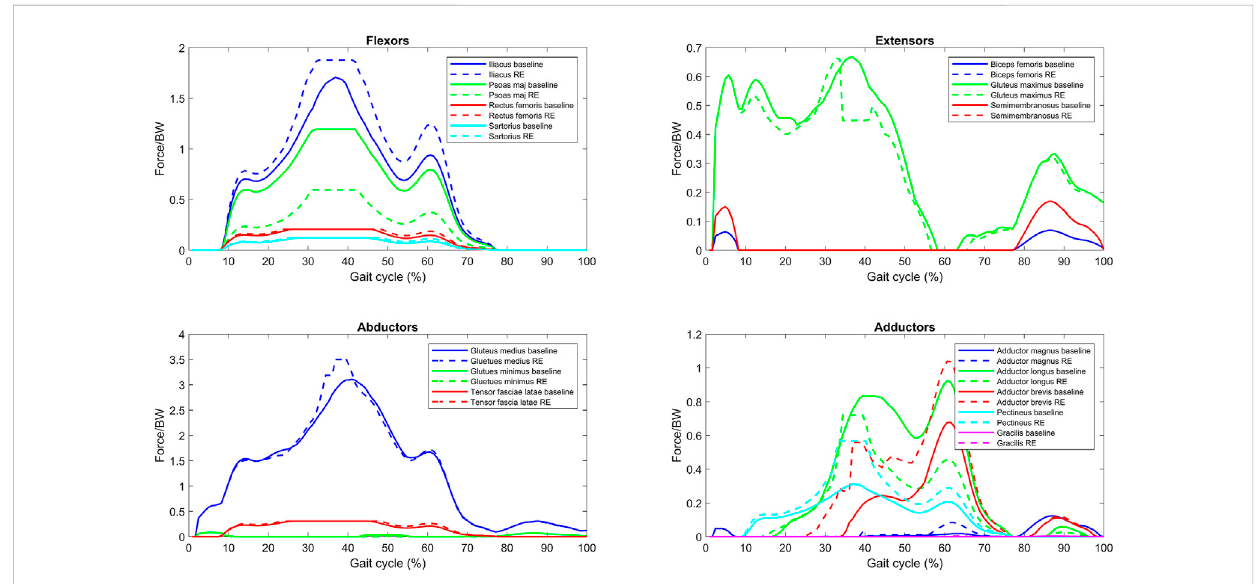
FIGURE 4 Normalized muscle force for one bilateral transfemoral person with limb loss for baseline and reduced endurance (RE) condition gait trial (reduce force capacity of the psoas major and adductor longus).